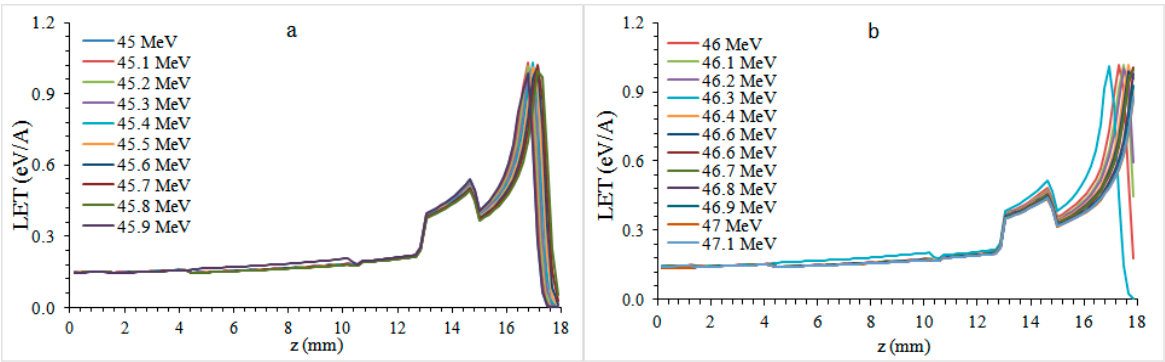
Figure 3. Bragg curves formed by 45–47.1 MeV ( a , b ) energy protons in premolar plate phantom.